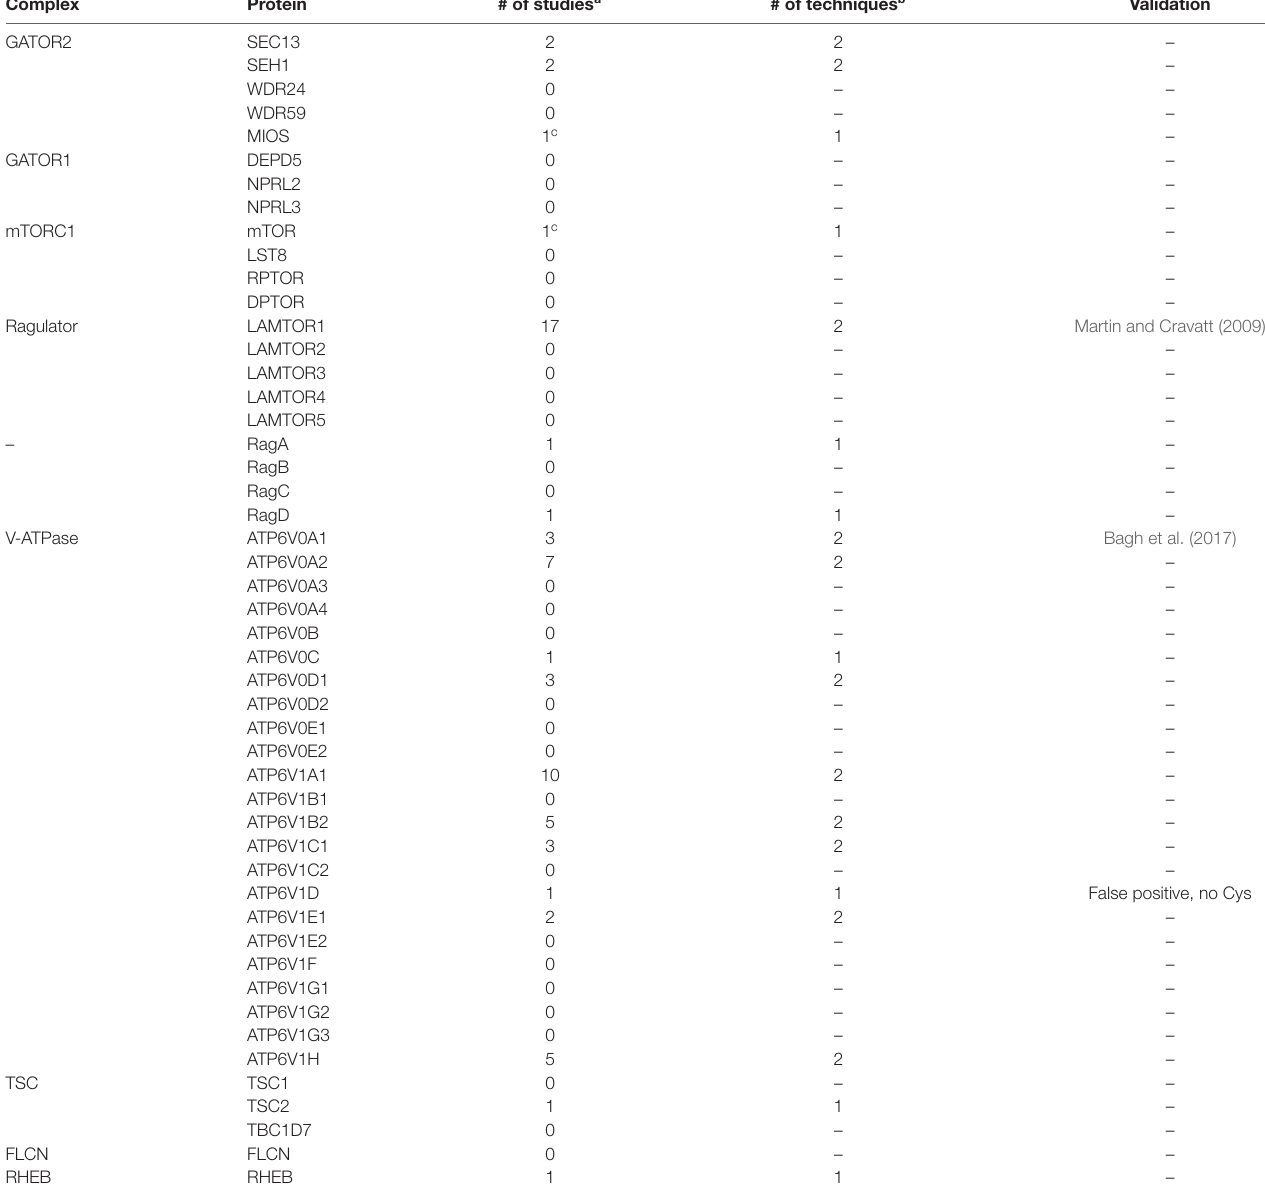
TABLE 1 | Mechanistic target of rapamycin (mTORC1) signaling proteins in palmitoyl-proteomic